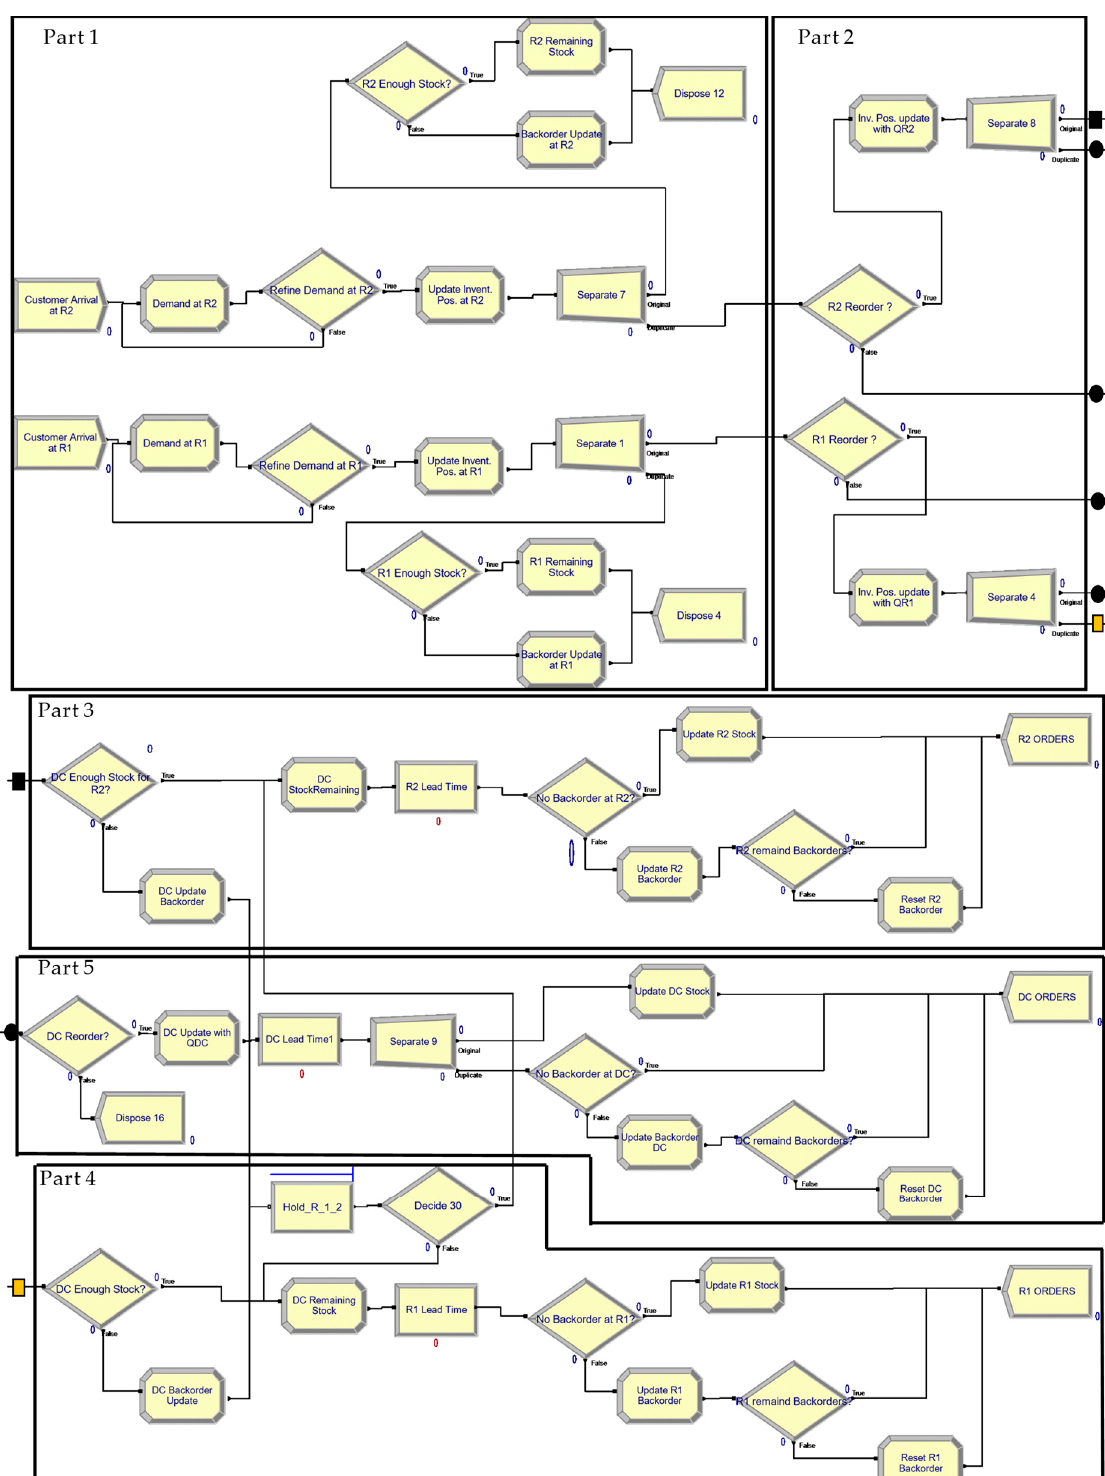
Figure 2. Arena network model of the ( 𝑄, 𝑟 ) two-echelon stochastic inventory system.